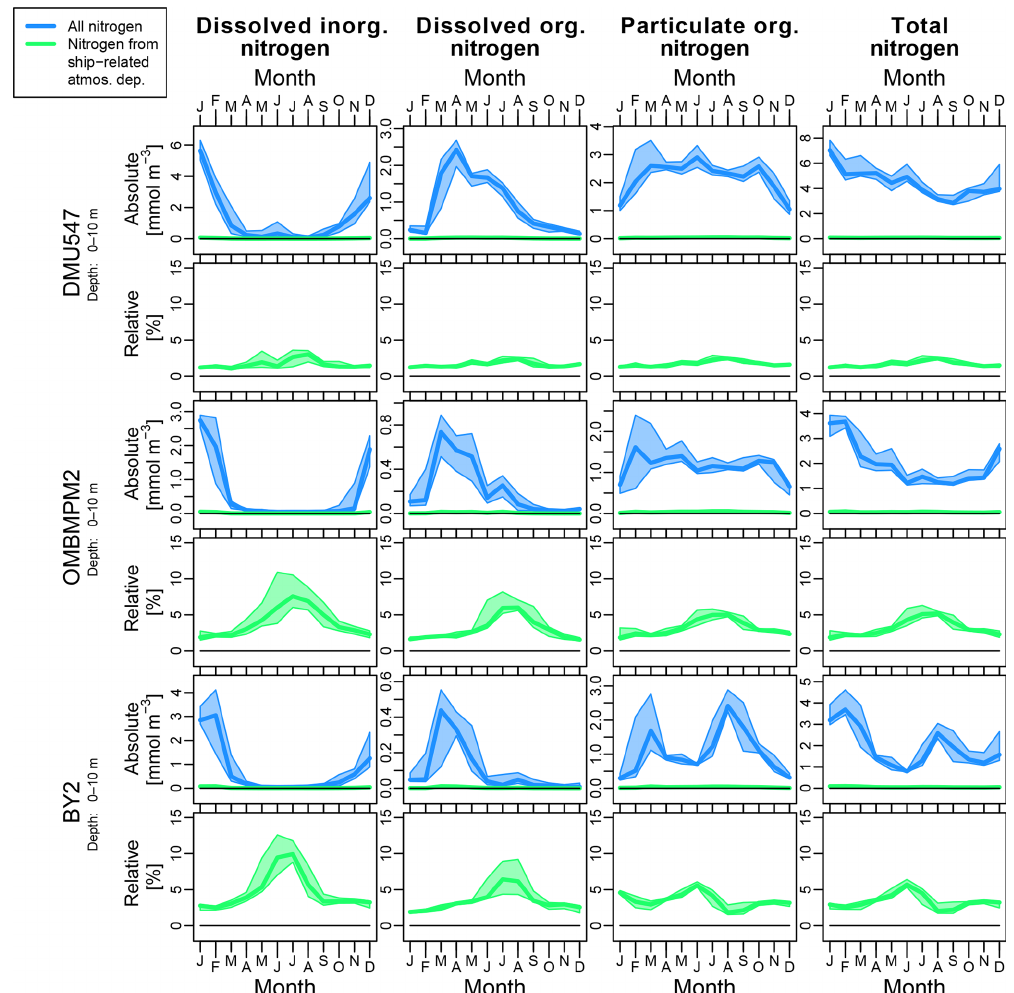
Figure 9. Similar to Fig. 8 but showing monthly median and percentiles calculated from daily data at specific station locations (Fig. 8 shows monthly percentiles calculated from monthly mean data and shows the variability in space). The stations are the same as in the validation. A similar figure showing data at the other three stations is provided in the